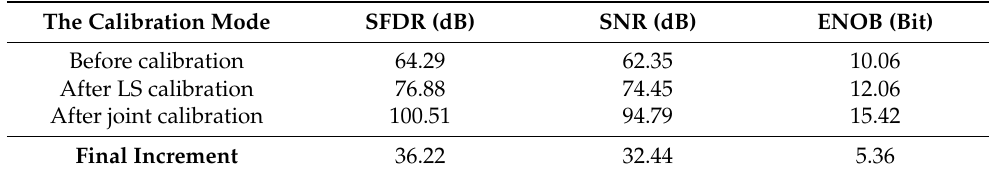
Figure 11. Error bit comparison before and after calibration. Table 1. Final calibration effect comparison of the 16-bit